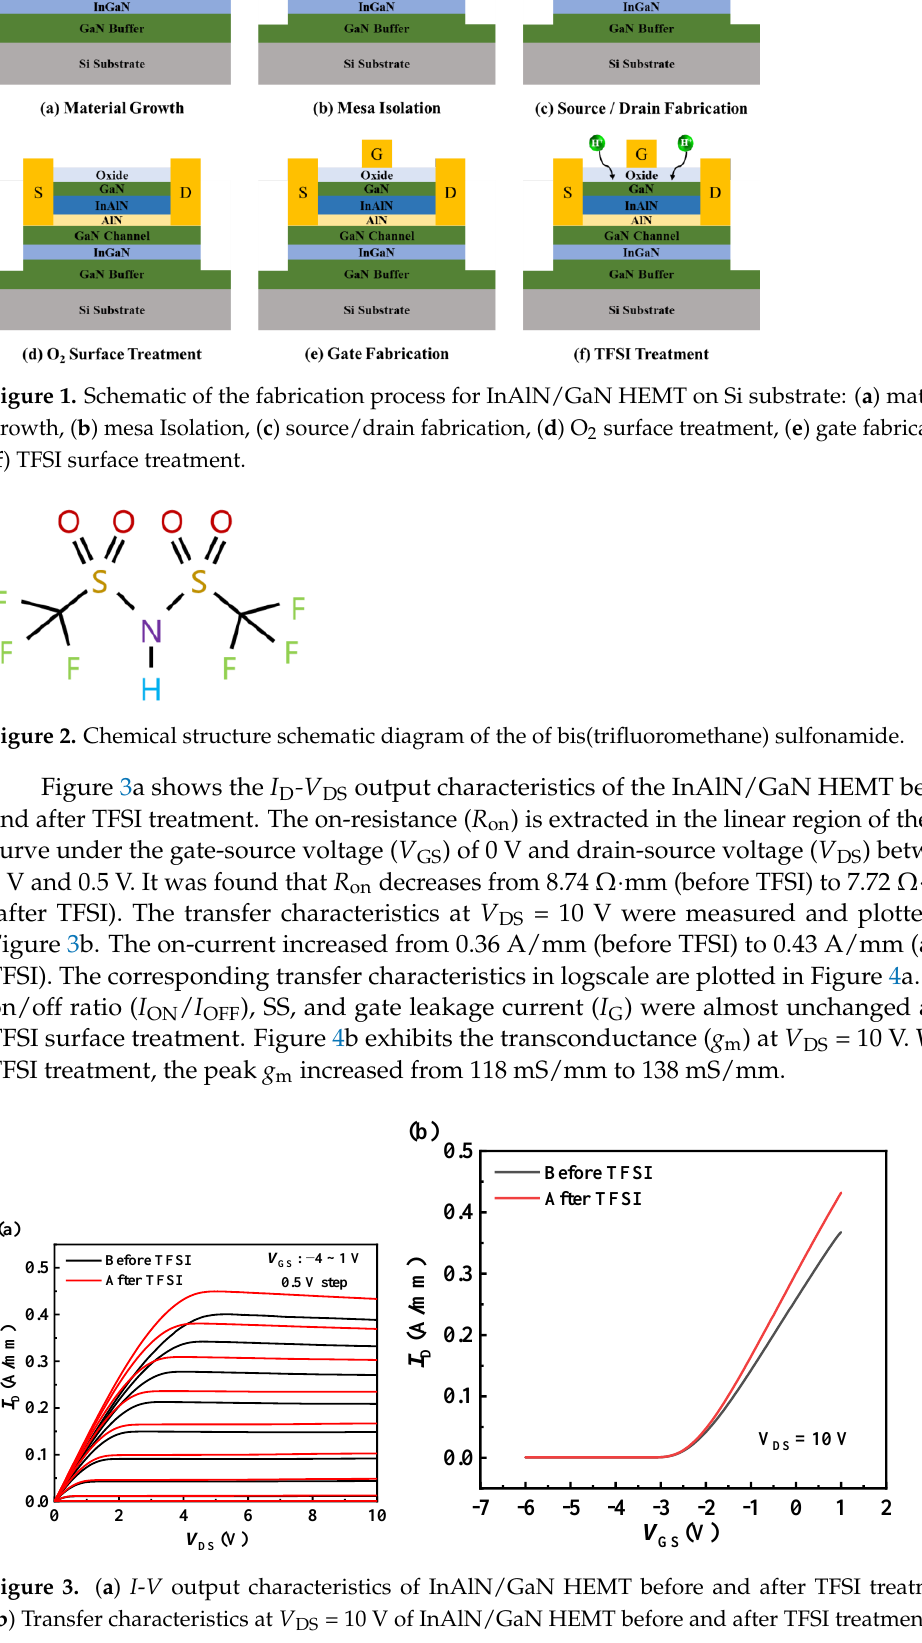
Figure 4. ( a ) Transfer characteristics in log-scale at V DS = 10 V of InAlN/GaN HEMT before and after TFSI treatment; ( b ) Transconductance at V DS = 10 V of InAlN/GaN HEMT before and after TFSI treatment. To investigate the effect of TFSI treatment, the gate capacitance of both samples was measured, as shown in Figure 5a. By integrating C - V curves [14], the 2DEG electron den- sity ( n 2D ) as a function of V GS was obtained, as shown in Figure 5b. It presents that the gate capacitance and the n 2D are almost identical before and after TFSI surface treatment. The 2DEG electron mobility under the gate region is calculated as follows: G n